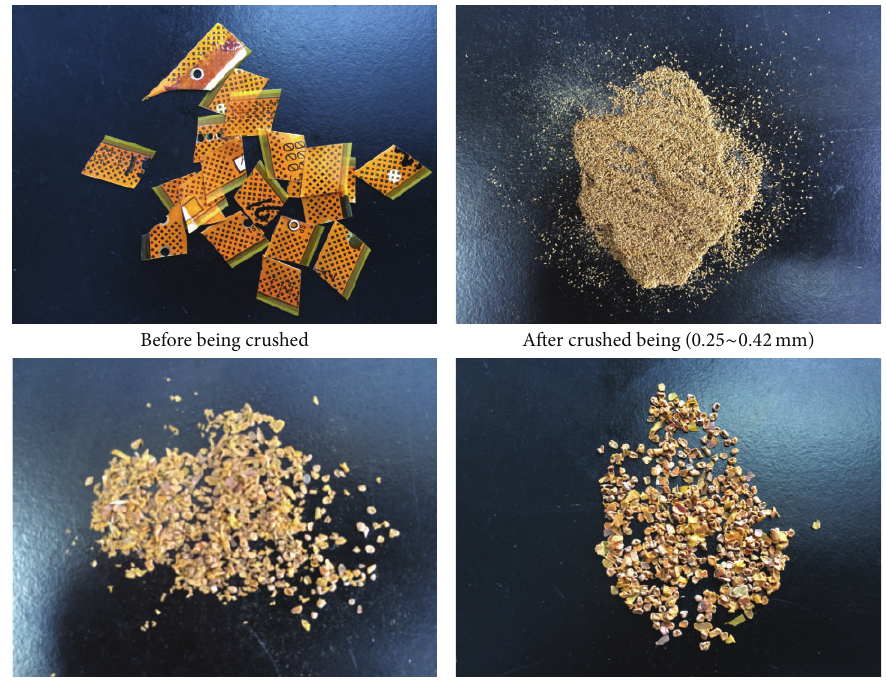
Figure 1: Flexible PCB before and after being crushed.